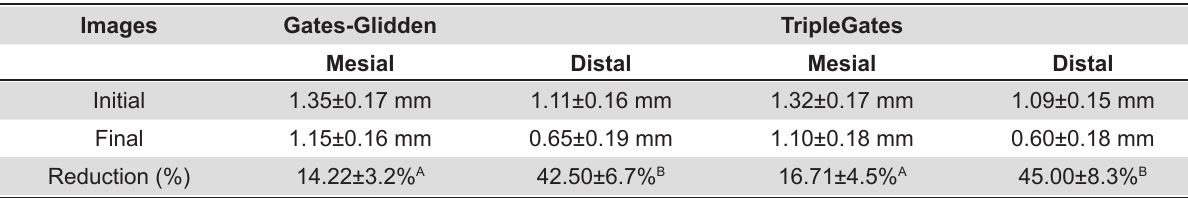
Different letters indicate statistical significant differences between the percentage of wear of the mesial and distal wall provided by the instruments tested